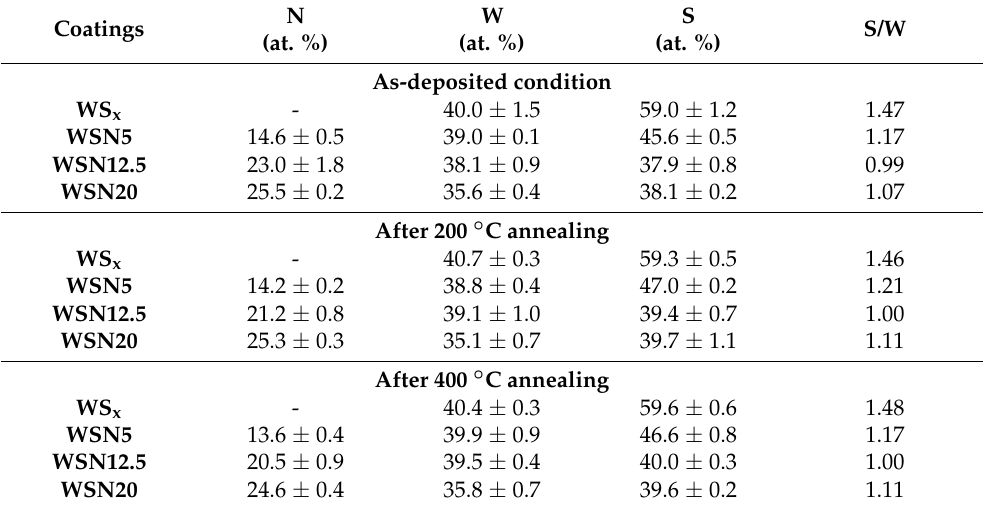
Table 2. Chemical composition of the as-deposited and annealed